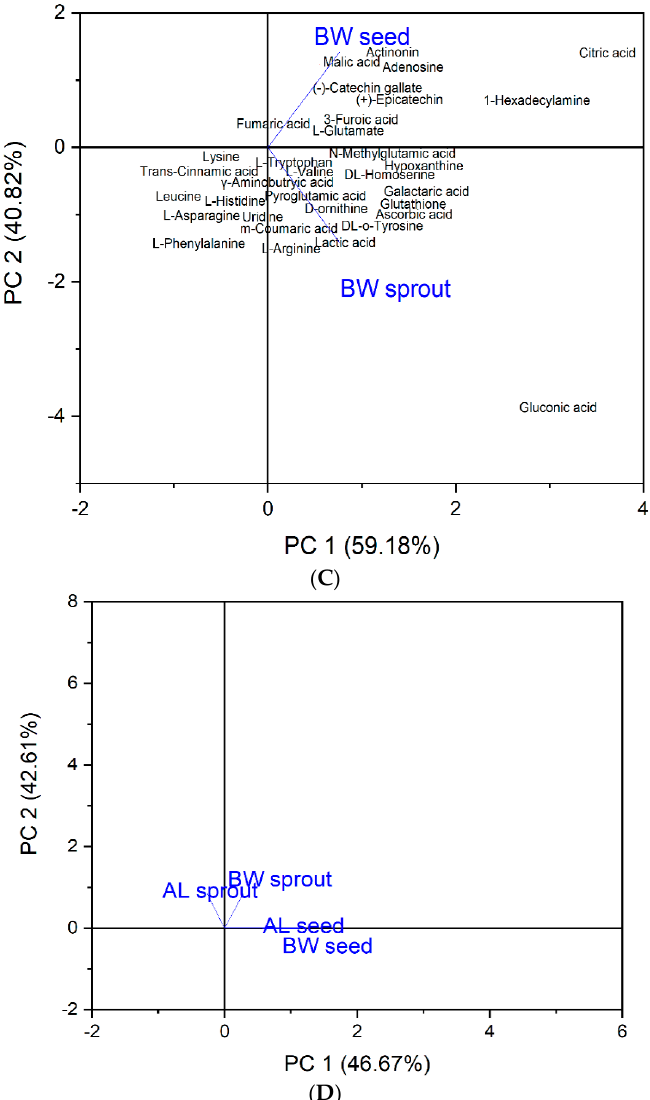
Figure 2. The heat map and biplots result from the heat map and PCA analysis of the metabolites. ( A ) Heat map figure showing the levels of the metabolites in the extracts. ( B ) Biplots of the metabolites identified in alfalfa seed and sprouts. ( C ) Biplots of the metabolites identified in buckwheat seed and sprouts. ( D ) Combined biplots for alfalfa and buckwheat (seed and sprouts). AL, alfalfa; BW, buckwheat.